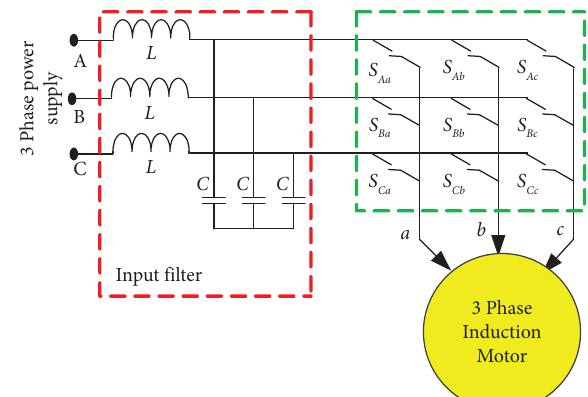
Figure 2: Tree-phase CMC with the load as the induction motor.